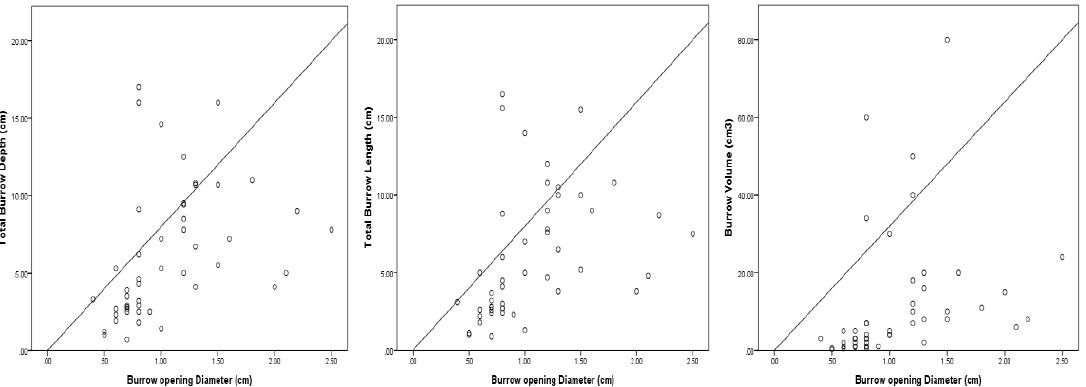
Figure 7. Relationship between burrow opening diameter and total burrow length (r = 0.40) and total burrow depth (r = 0.39) at 1% level or burrow volume (r = 0.31; p < 0.05).